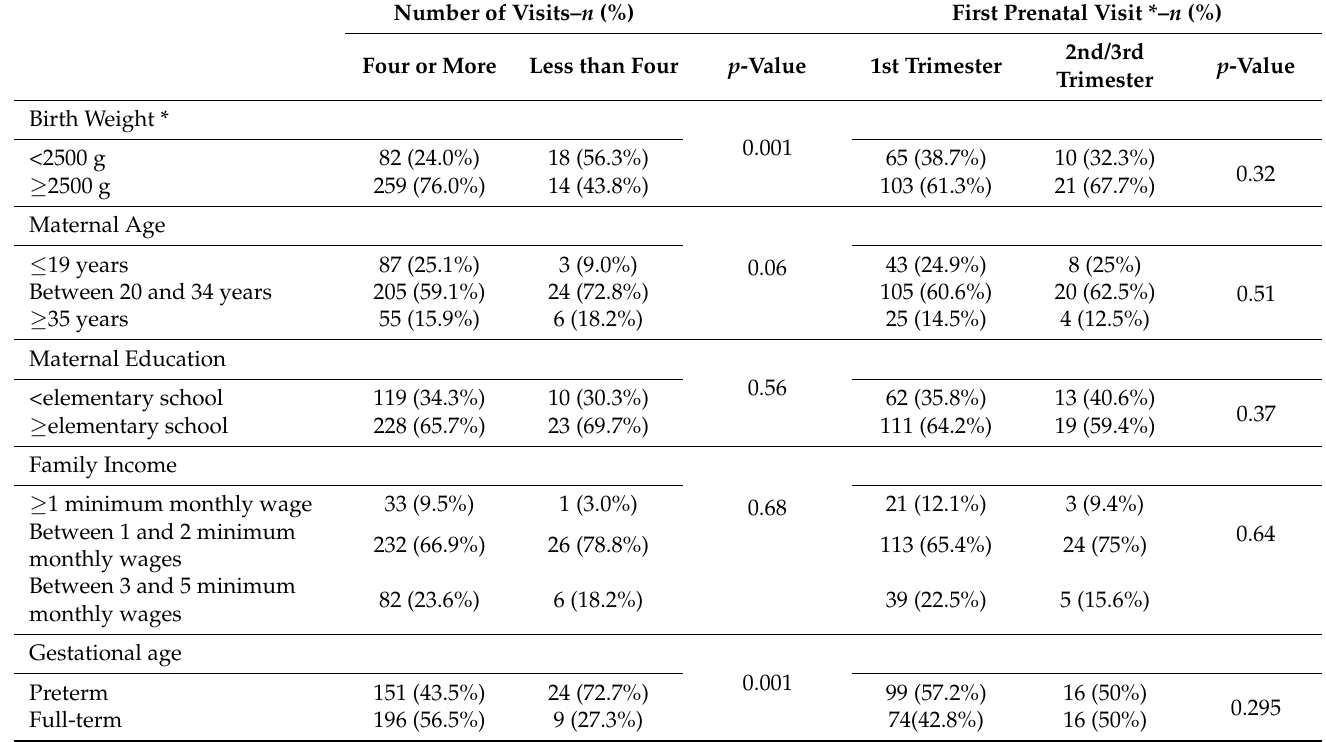
Table 1. Sample characterization according to prenatal